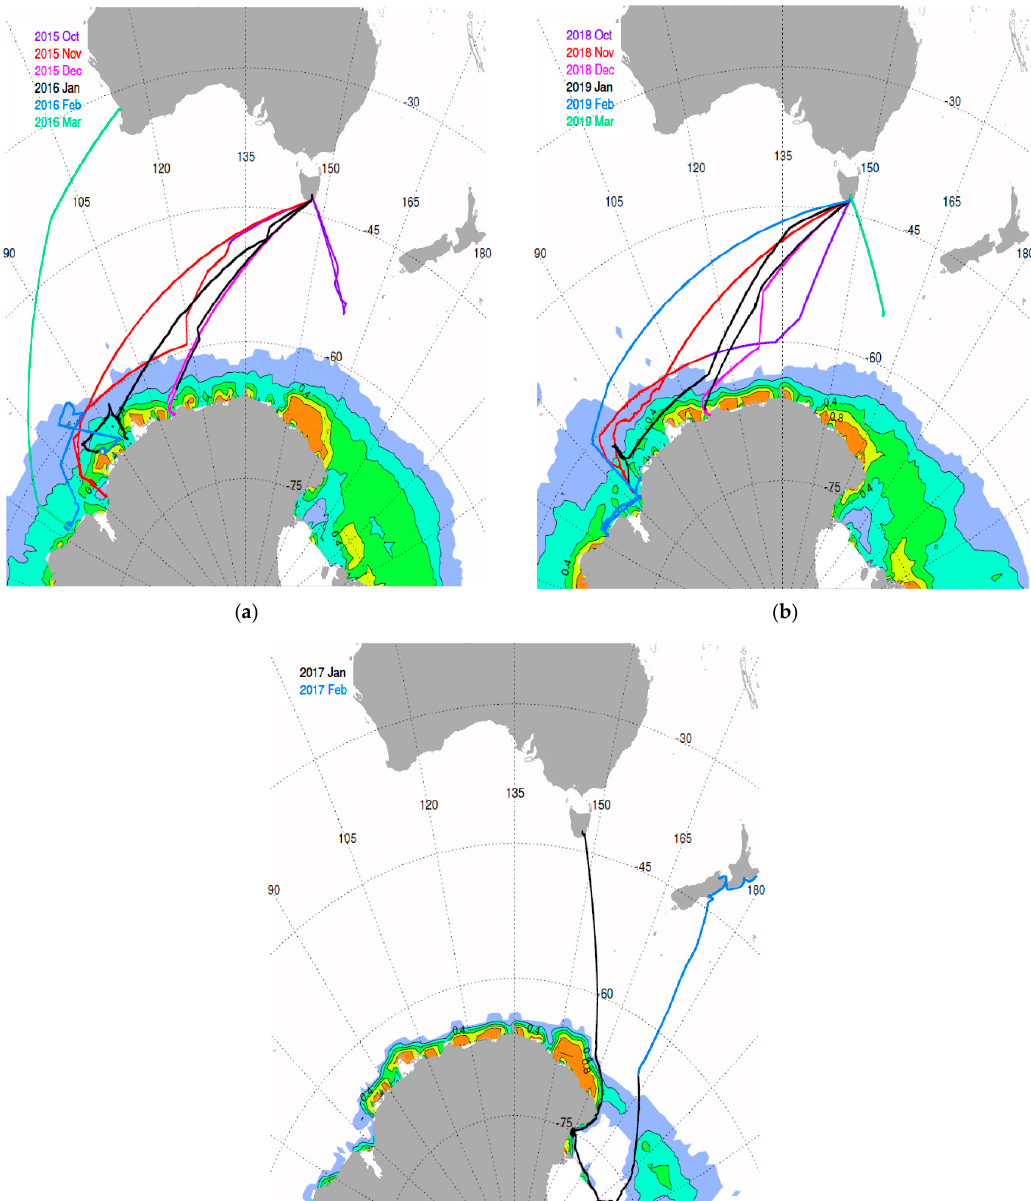
Figure 1. Colour-coded ship tracks for each month during the voyages of ( a ) RSV Aurora Australis over the period October 2015 to March 2016, ( b ) RSV Aurora Australis over the period October 2018 to March 2019 and ( c ) MS The World over the period of January to February 2017. The contours of sea ice fraction (0.2, 0.4, 0.6, 0.8, 1.0) are overlaid in different colours based on NOAA Optimum Interpolation Sea Surface Temperature version V2 data. The sea ice concentration data have been averaged over November 2015 to February 2016 for ( a ), over November 2018 to February 2019 for ( b ), and over January 2017 for ( c ).